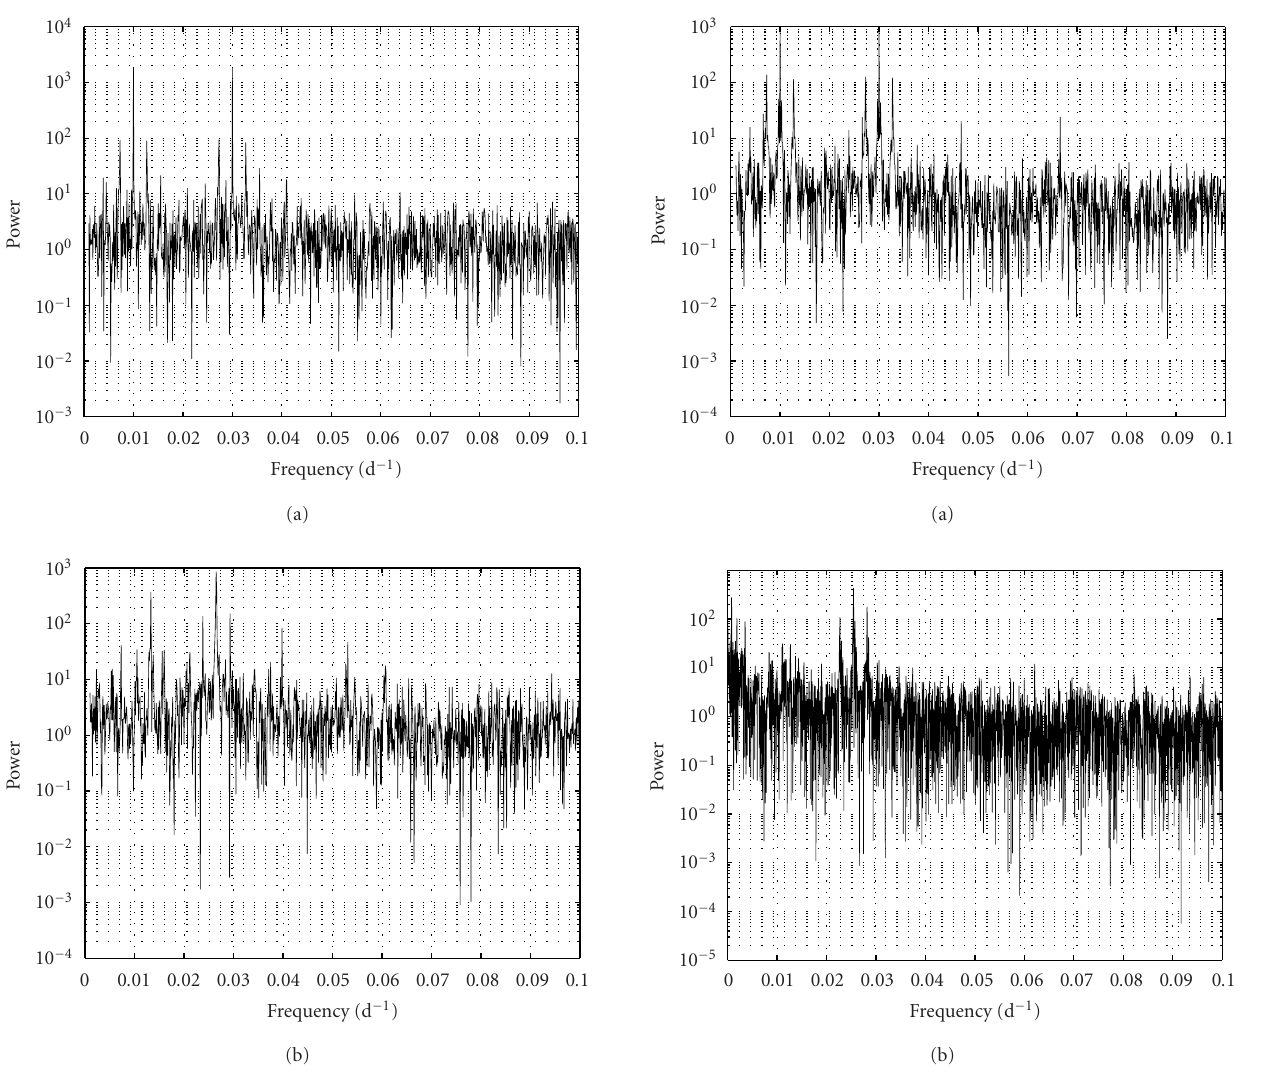
Figure 3: Periodograms from the AC Herculis light curve (b) and from the corresponding simulated signal (a), presented on a loga- rithmic scale.